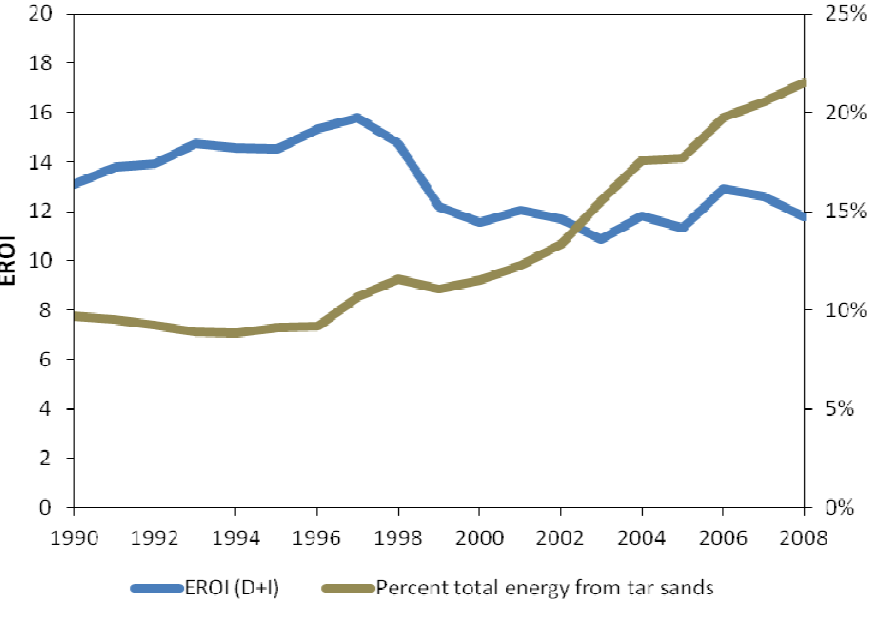
Figure 6. EROI of total Canadian Oil and Gas, and Percent total oil and gas energy coming from Tar